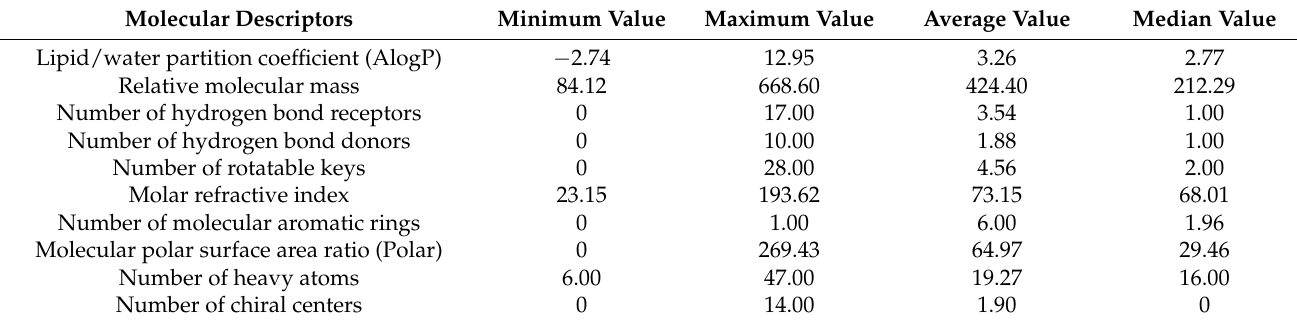
Table 5. Molecular descriptors of compounds contained by